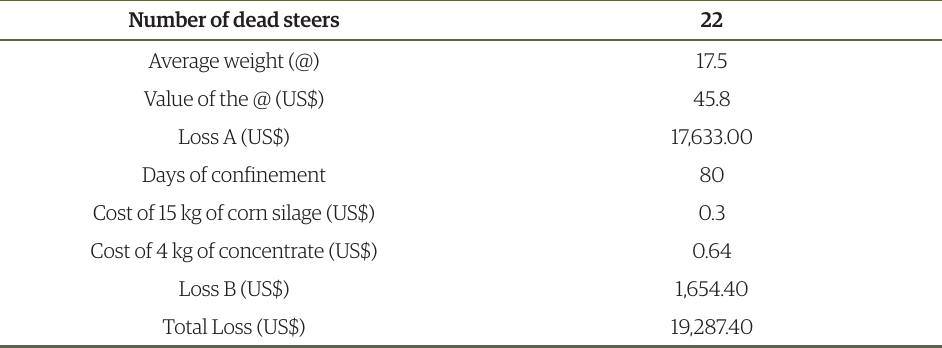
Table 1. Estimation of economic losses due to the outbreak of botulism in beef